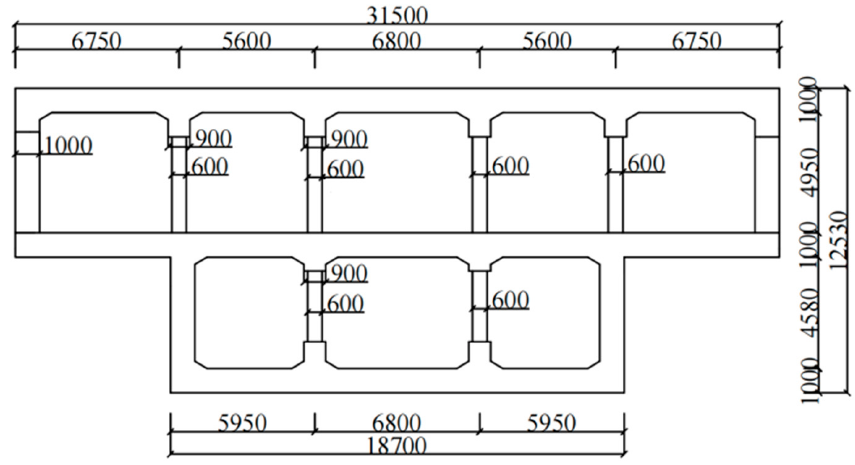
Table 1. Values of parameters.